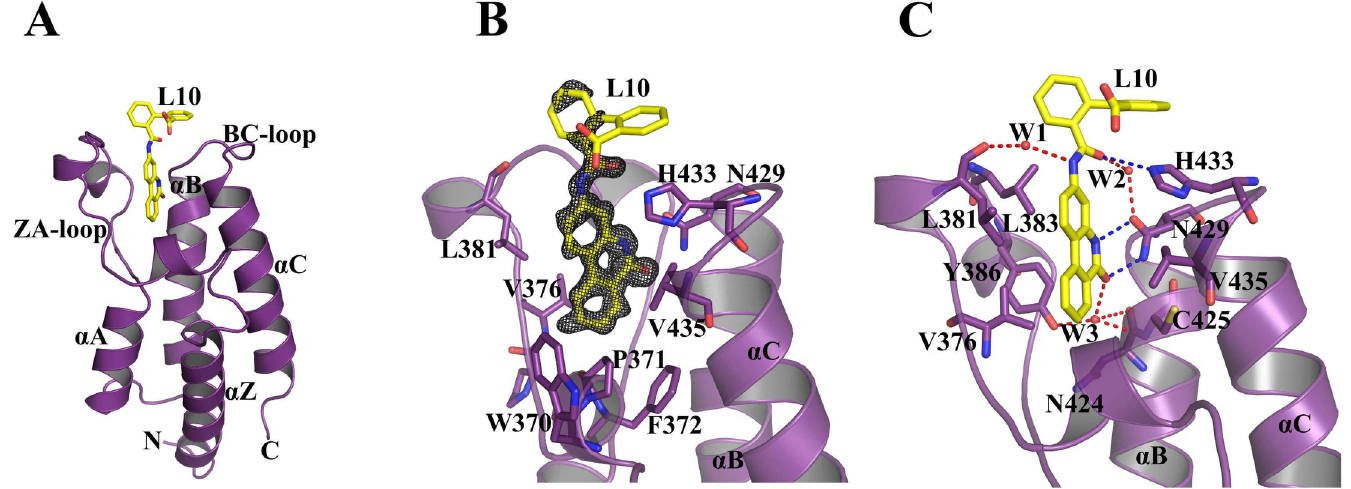
Fig 1. The structure of BRD2-BD2 in complex with L10. (A) The tertiary structure of the BRD2-BD2 complex with the compound L10 bound to the active site. ( B) | 2Fo|-|Fc| map of L10 contoured at 1.0 σ in the binding pocket of BD2. (C) A close-up view of BD2-L10 interactions. The direct hydrogen bonds are indicated by blue (L10 to H433 and N429) and water mediated ones (through W1, W2, and W3) are indicated by red dotted lines. The water molecule W3 is involved in a three-way hydrogen bond to Y386-OH, N424-O, and C425-NH in addition to the interaction with L10-O9. The water molecule W1 bridges L10-N12 and L381-O. The water molecule W2 forms a similar bridge between L10-O29 and N429-OD1. The ligand and interacting residues are shown as sticks. Water molecules are shown as spheres. The hydrogen bonds are shown as broken lines.